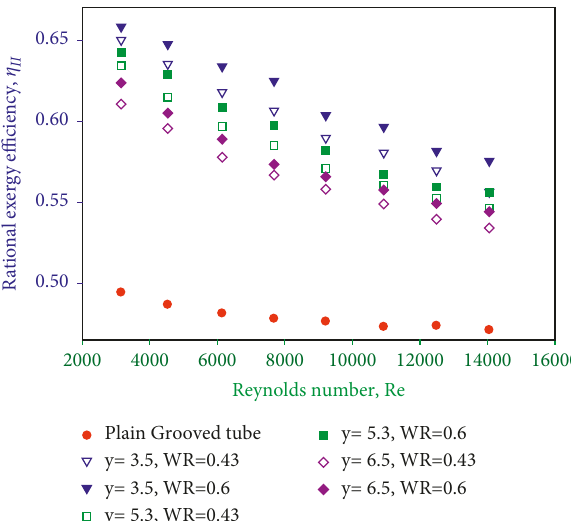
Figure 11: Exergy efficiency ( η